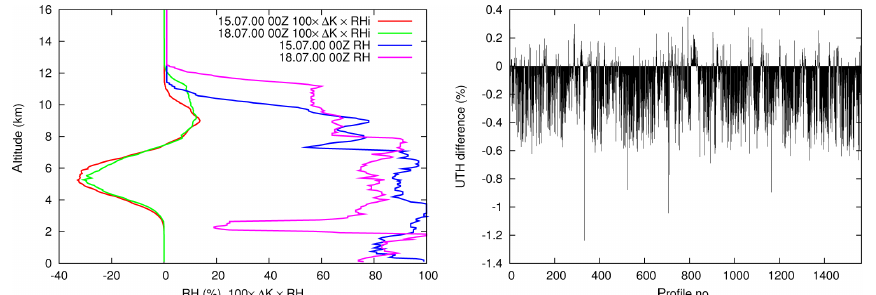
Figure 4. Left: profiles of relative humidity (with respect to water) measured with radiosondes launched at Lindenberg, Germany on 15 July 2000, 00:00UTC (blue) and 18 July 2000, 00:00UTC (magenta); these profiles have been multiplied with the difference of the two kernel functions of Fig. 3, resulting in the red profile for 15 July and the green profile for 18 July. Right: differences of UTH when the two kernel functions of Fig. 3 are applied to 1564 profiles of RH, measured from February 2000 to April 2001 with radiosondes launched at Lindenberg,